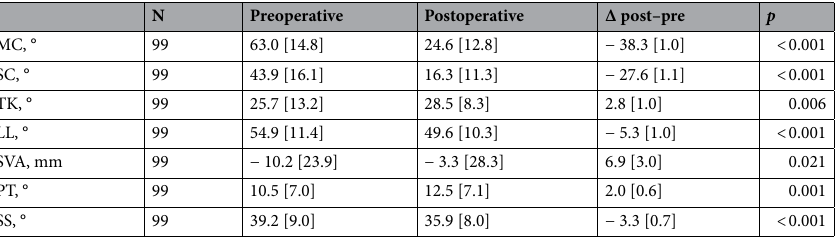
Table 5. Radiographic parameters in group 1 (all-screws group); mean [standard deviation]; analysis performed using IBM SPSS Statistics 21. LL, lumbar lordosis; MC, Cobb angle of the main curve; N, number of patients; PT, pelvic tilt; SC, Cobb angle of the secondary curve; SS, Sacral Slope; SVA, sagittal vertical axis; TK, thoracic kyphosis.